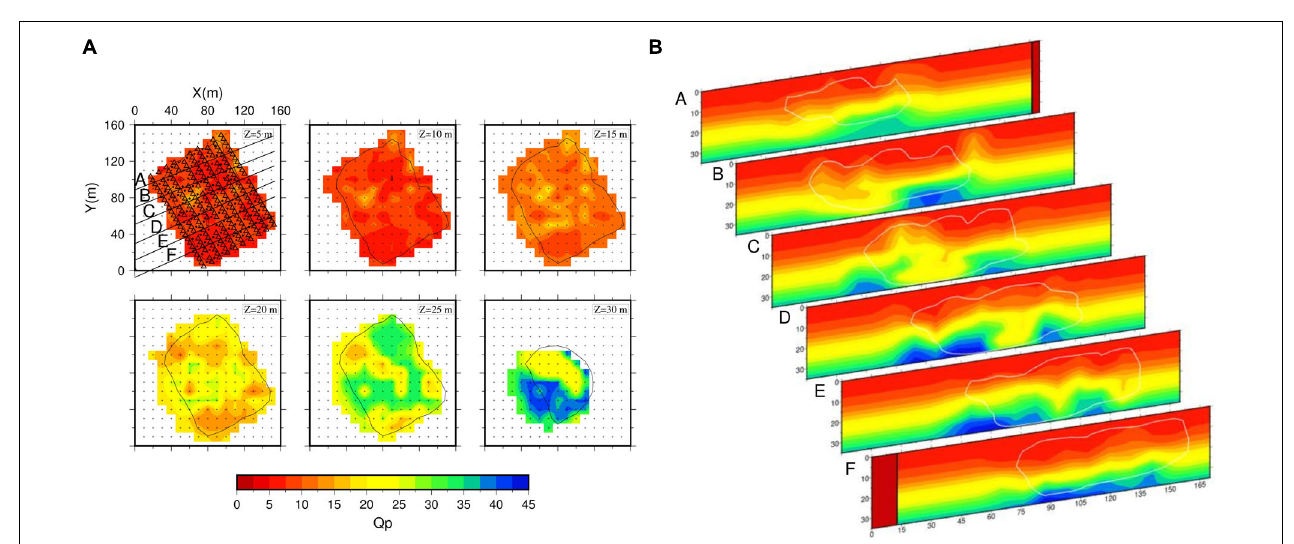
FIGURE 9 | 3-D Q P attenuation model. (A) Horizontal slice of P-wave attenuation model at different depths. The black contour delimitates the resolved area, i.e., the area for which the DWS is higher than the threshold value (see Figure 8 ). This threshold value is chosen binding the RDE to be higher than 0.85 (see Supplementary Figures S8, S9 ). The white regions in each slice represent areas not covered by rays. (B) P-wave attenuation model projected onto the NE-SW cross-sections located in A . The black contoured regions in each slice represent resolved areas.